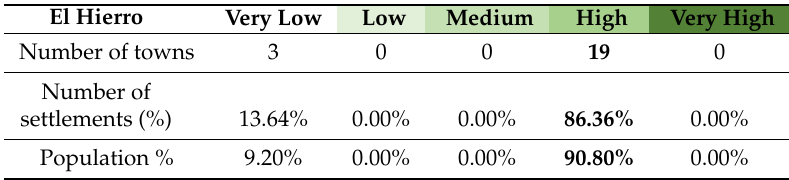
Table 4. Outcomes regarding the demographic dynamics and urban agglomerations classified according to the accessibility levels in the Island of El Hierro (Source: authors).